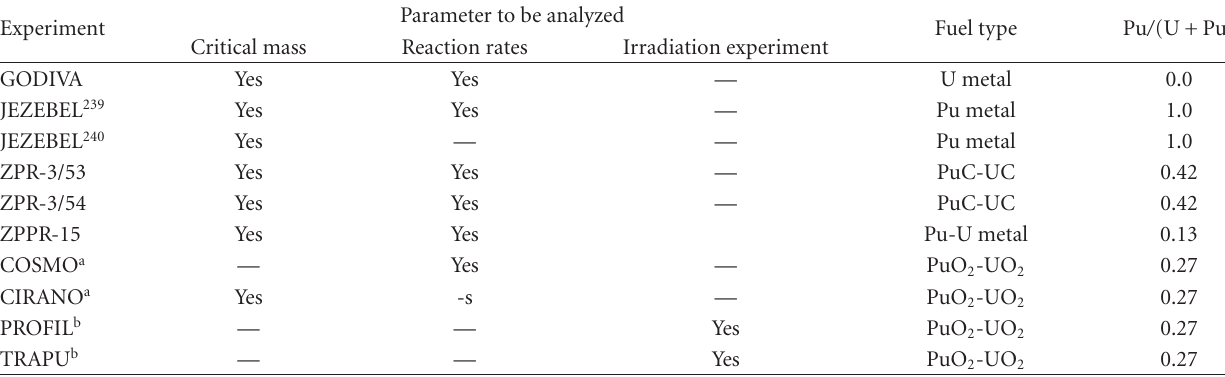
Table 2: List of integral experiments to be used in the statistical adjustment.